Question: How would you classify this visualization?
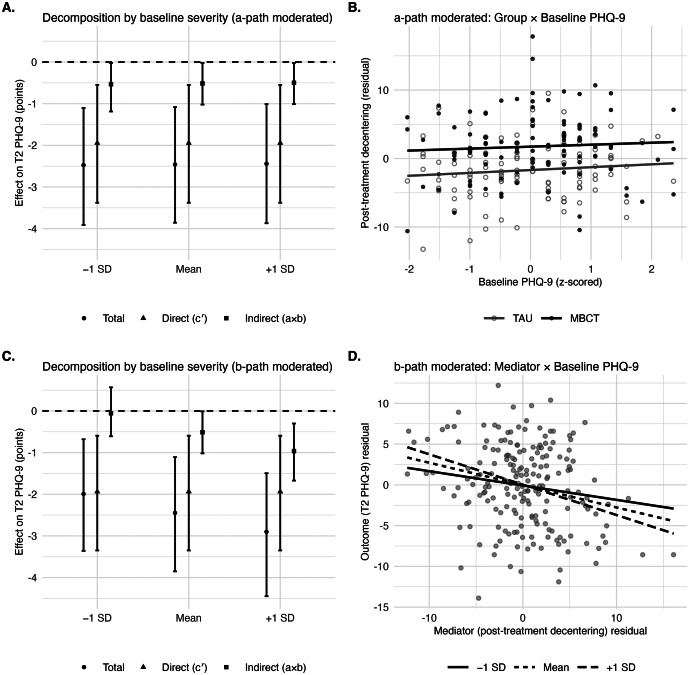
Answer: bar